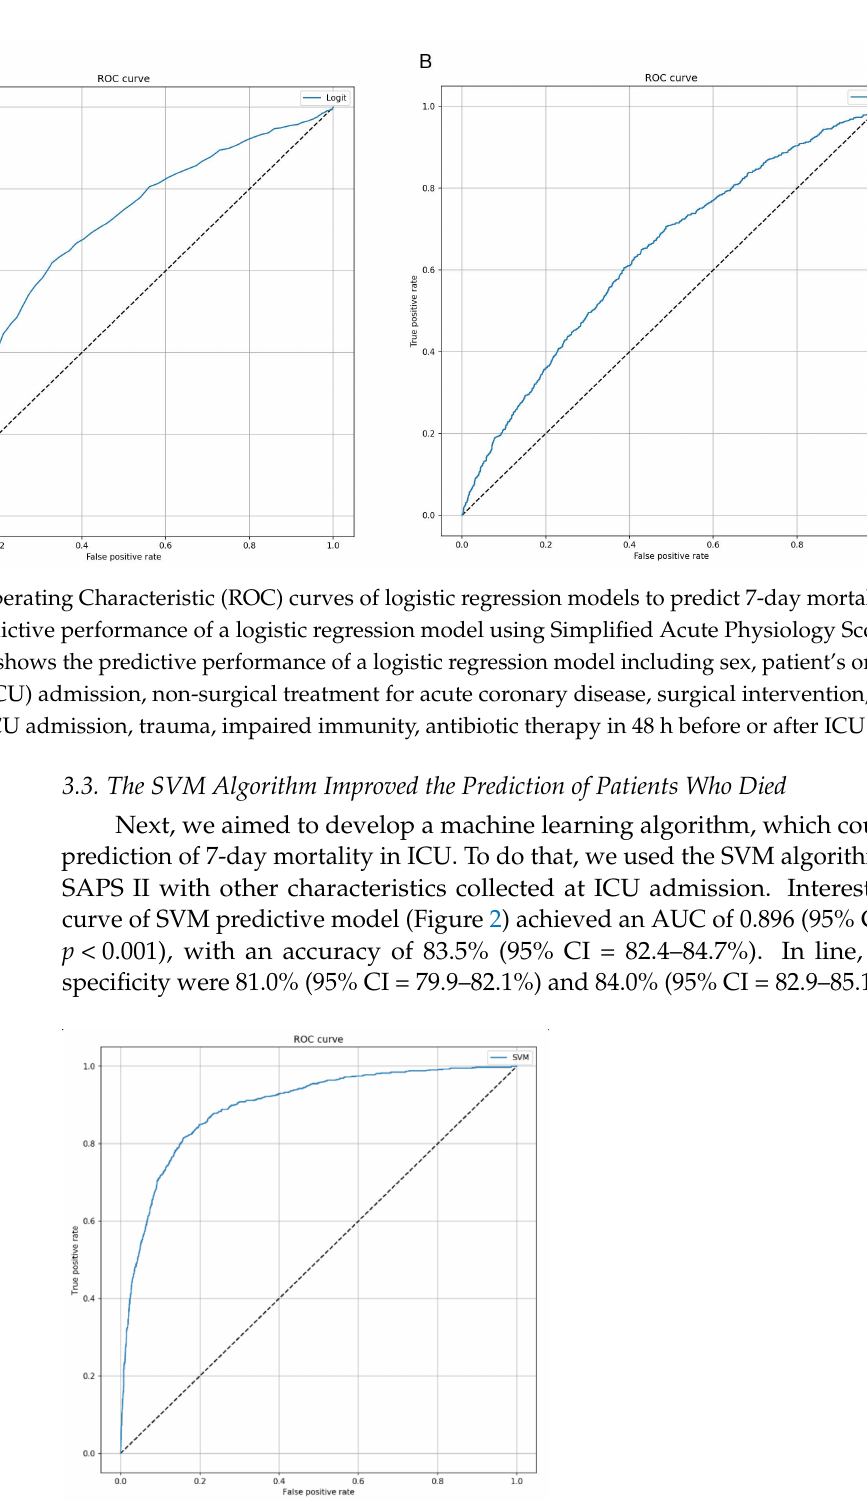
Figure 2. ROC curve of the Support Vector Machines (SVM) algorithm to predict 7-day mortality. This curve shows the predictive performance of the SVM algorithm including SAPS II, sex, patient’s origin, type of ICU admission, non-surgical treatment for acute coronary disease, surgical intervention, presence of invasive devices at ICU admission, trauma, impaired immunity, antibiotic therapy in 48 h before or after ICU admission. The parameters applied to the SVM algorithm were C = 2 and γ =